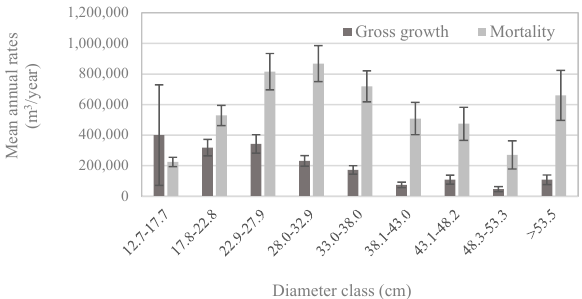
Figure 5. Population estimates of the mean annual volume of gross growth and mortality of whitebark pine trees by diameter class, based on trees measured between 2005 and 2015 ( n = 404 plots; measurement years vary by state) among all forest types. Error bars represent +/ − one standard error [20].